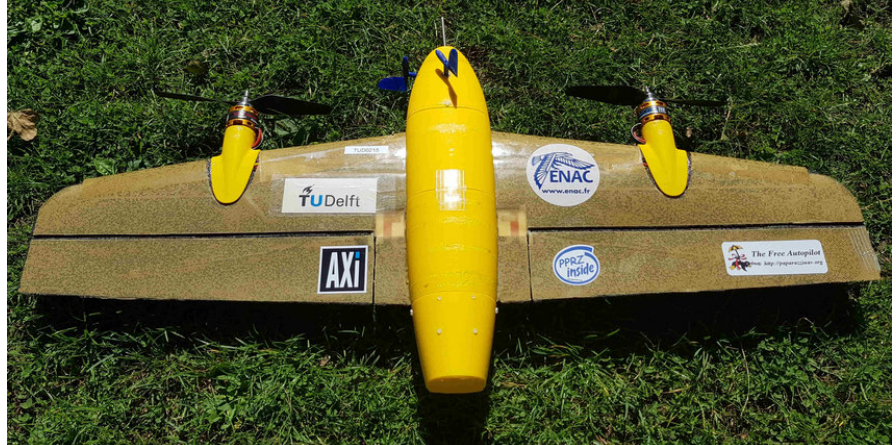
Figure 1. The Cyclone hybrid tail-sitter